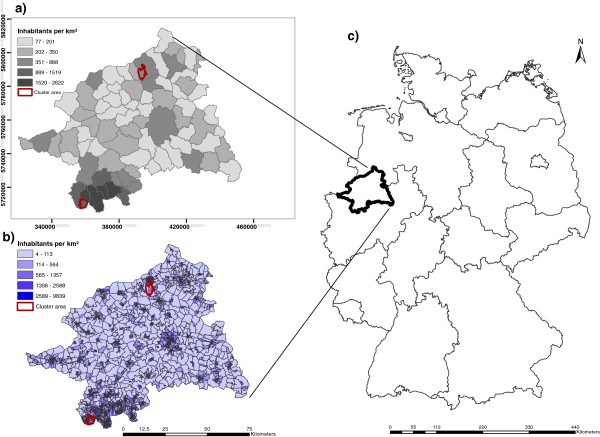
Overview of the study area (Regierungsbezirk Münster) with the modelled cluster areas. Two different spatial aggregation scales are shown: (a) the 78 communities and (b) the 1983 census tracts with the associated population density. Location of the study area in Germany (c).